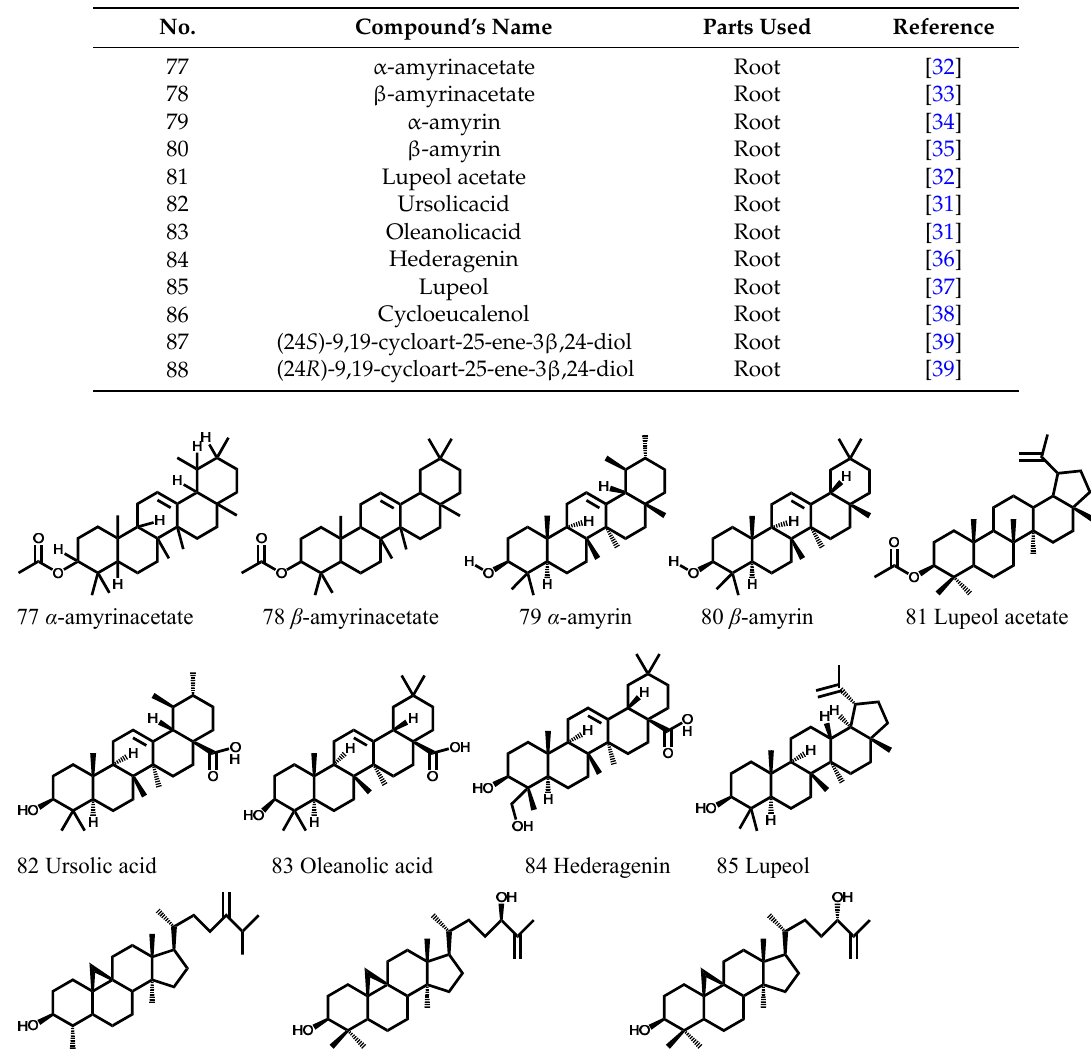
Figure 4. The structures of terpenoids (77–88) obtained from Cortex Periplocae .